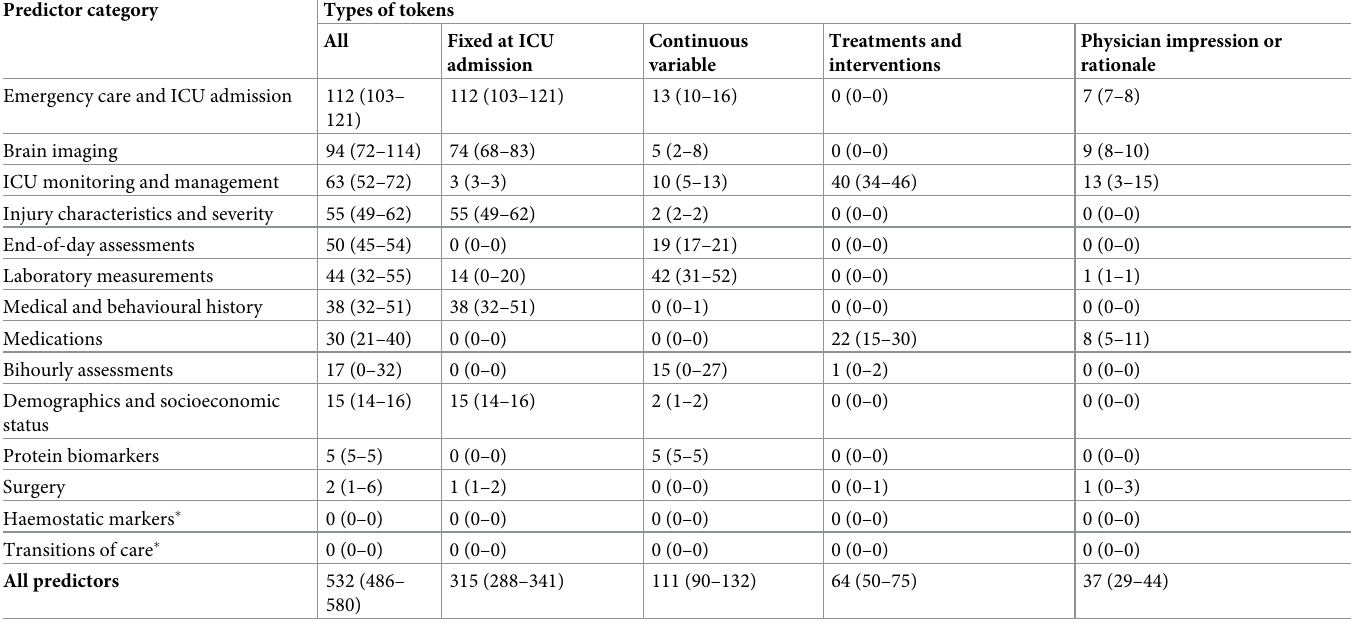
Table 3. Predictor baseline tokens per patient in the CENTER-TBI